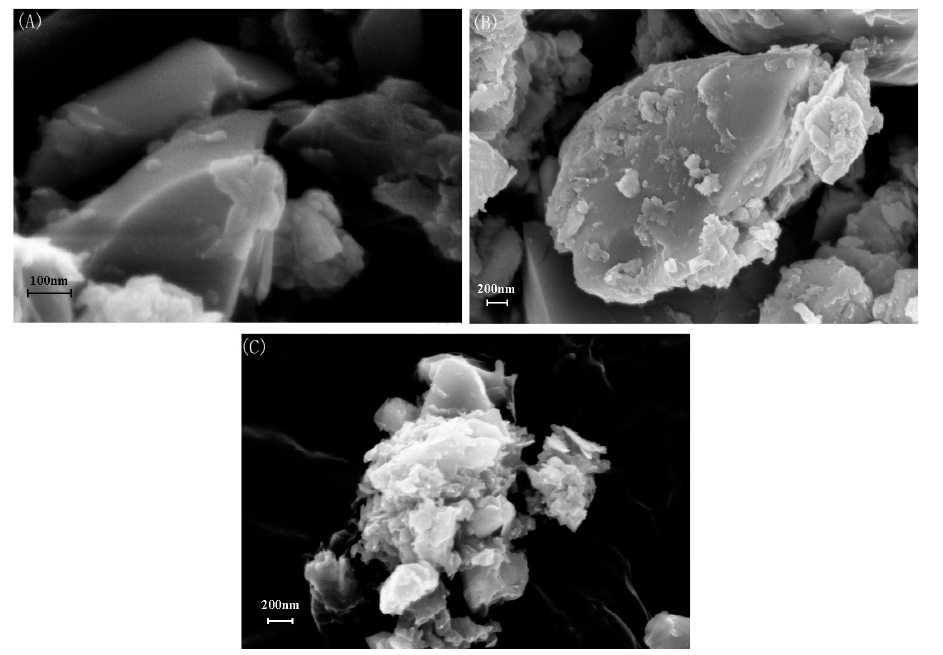
Figure 6. SEM images of: ( A ) BiYTi 2 O 7 -1%PANI; ( B ) BiYTi 2 O 7 -5%PANI; and ( C ) BiYTi 2 O 7 -10%PANI.